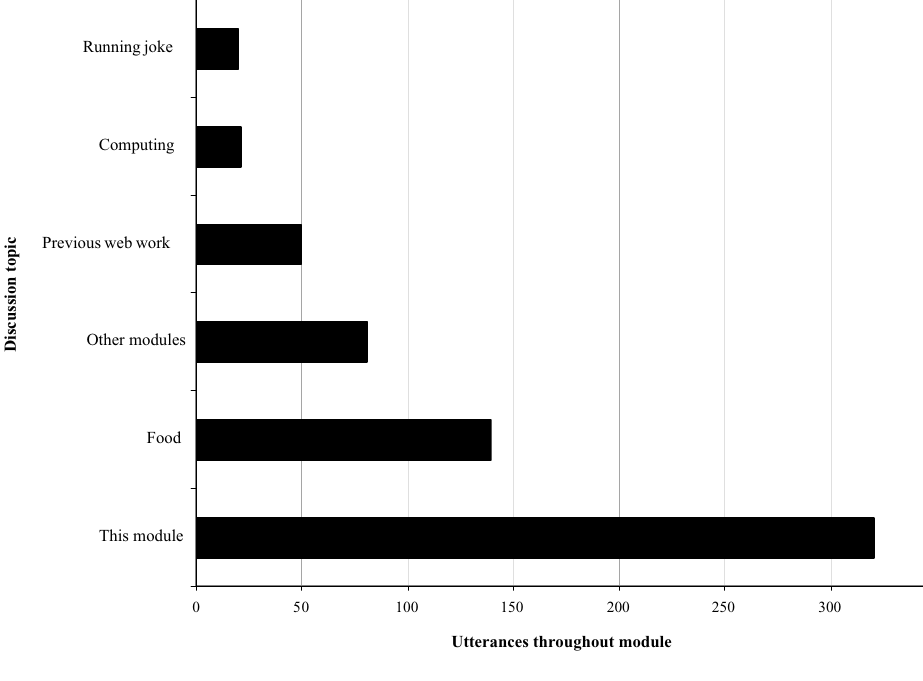
Figure 2. The frequencies of utterance of topics throughout the module